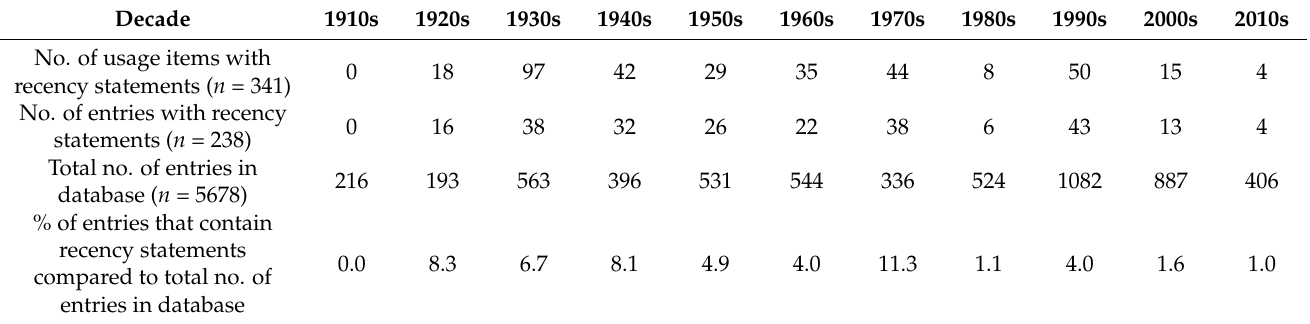
Table 2. Recency statements per decade as raw frequency and percentage of total amount of